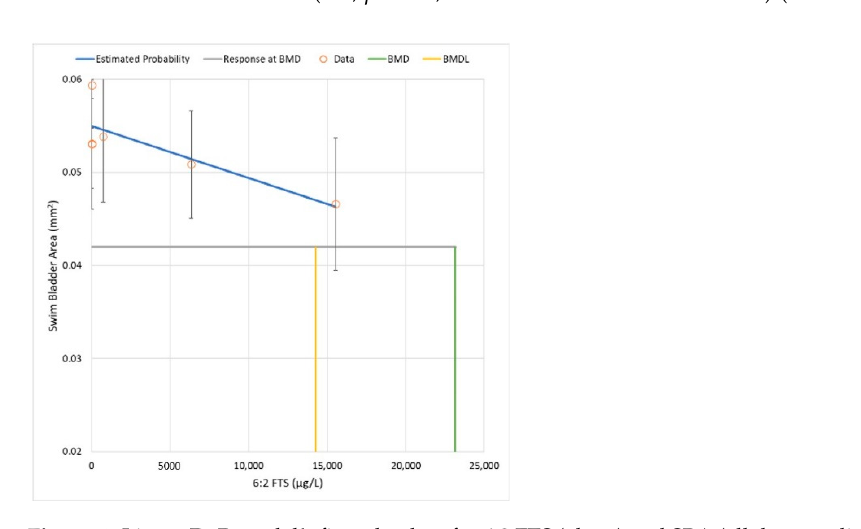
Figure 4. Linear D–R model’s fit to the data for 6:2 FTS (alone) and SBA (all three replicates com- bined). The BMD (23,200 µg/L) and BMDL (14,260 µg/L) correspond to a BMR of one control